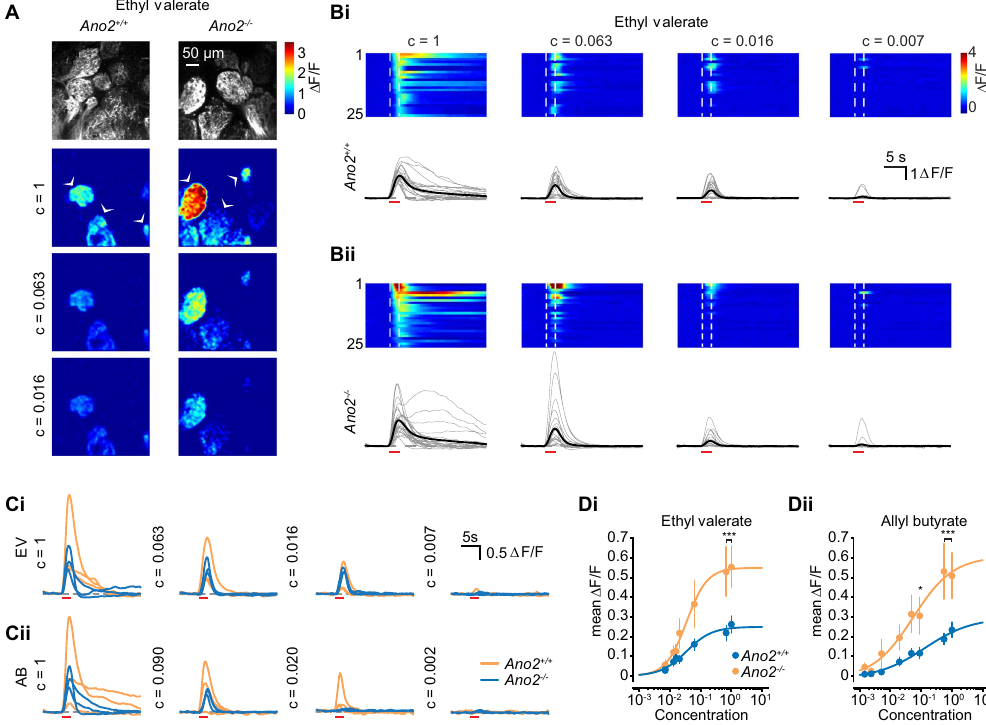
Figure 5. ORN responses in Ano2 − / − animals are enhanced at high odor concentrations. ( A) Example multiphoton-acquired images of glomeruli and Δ F/F responses at three odor concentrations. Odor concentrations were normalized to the highest concentration (~10% v/v) using a photoionization detector (see Supplemental Fig. 4). ( Bi-ii) Examples of the 25 largest responses to the highest concentration of Ethyl valerate followed through four other concentrations for Ano2 + / + (top) and Ano2 − / − (bottom) animals. Individual traces are displayed below. Dashed line denotes odor onset and offset, red bar indicates odor period. ( Ci-ii ) Example traces from three glomeruli in part A, identified by arrowheads followed through four concentrations of Ethyl valerate (EV; top) and Allyl butyrate (AB; bottom) Di-ii . Mean response (filled circles) at eight odor concentrations for both odors and sigmoidal fit to each (Wilcoxon rank-sum, * p < 0.05, ** p < 0.01, *** p <